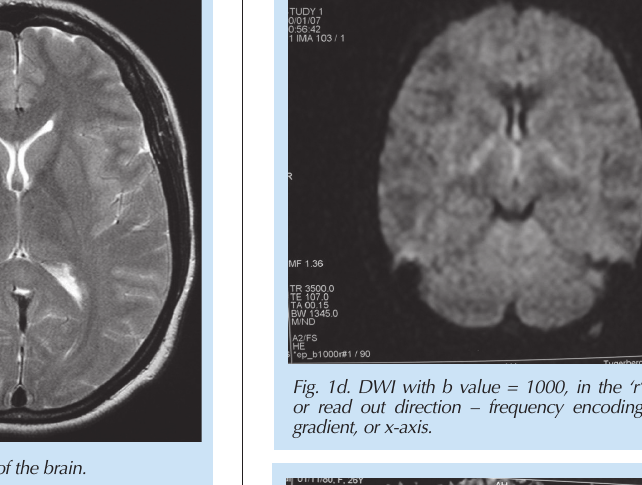
Fig. 1a. Axial T2WI of the brain.